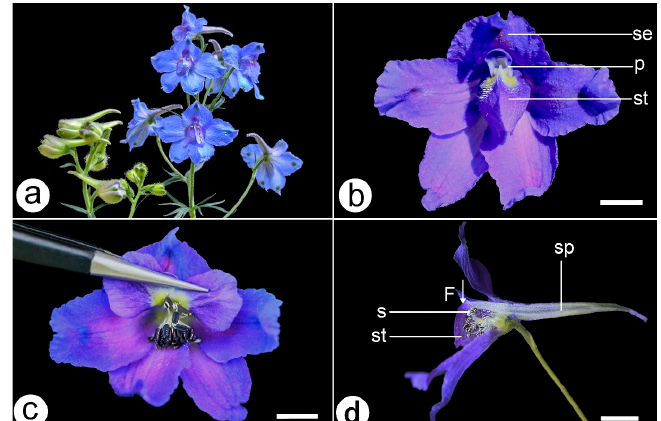
Figure 2. D. caeruleum in Gannan Tibetan Autonomous Region, China. ( a ), flowering plant of D. caeruleum. ( b ), detailed floral structure of D. caeruleum (p—petals, se—sepals, st—staminodes). ( c ), the pistils and stamens below the staminodes. ( d ), side longitudinal section view of D. caeruleum (s—stamens, sp—spur, st—staminode), arrow (F) denotes the direction in which visitors land and press the staminodes. Scale bars = 5 cm.